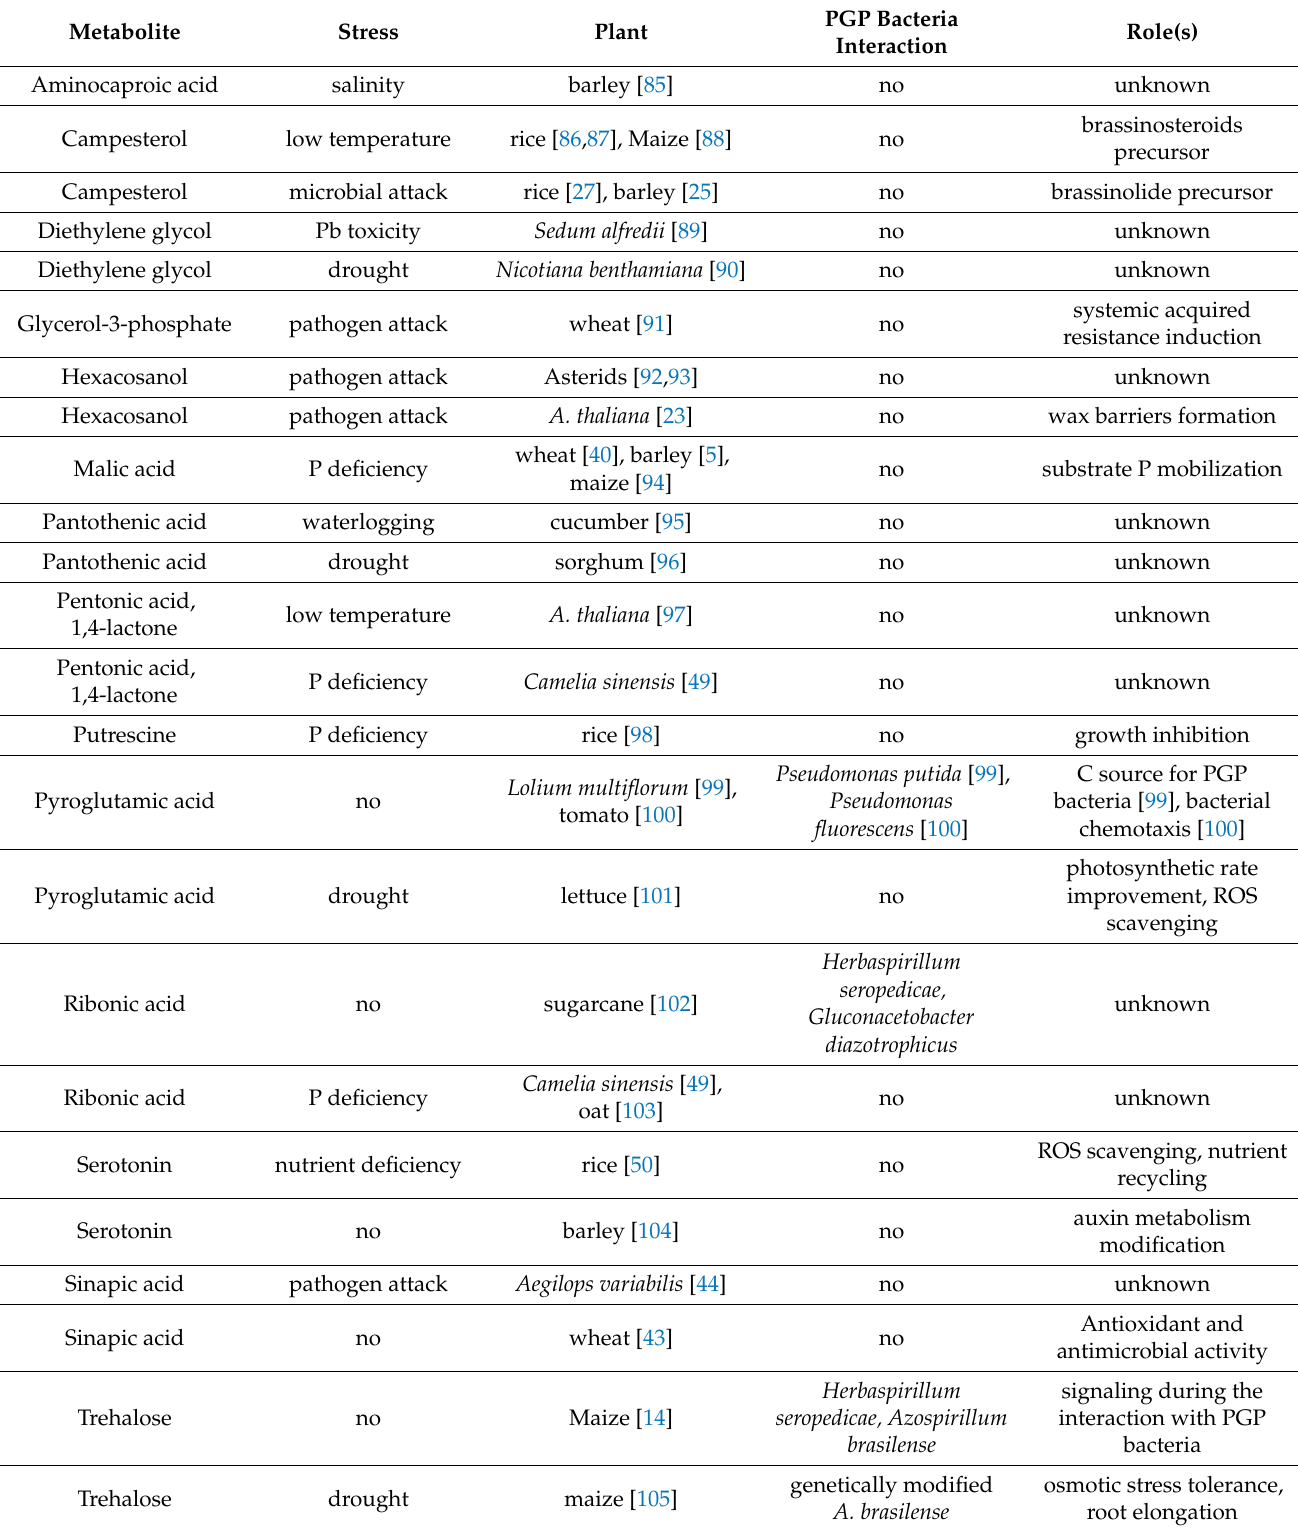
Table A1. Reports on compounds affected in our study, in relation to plant response to stress and/or interaction with PGP